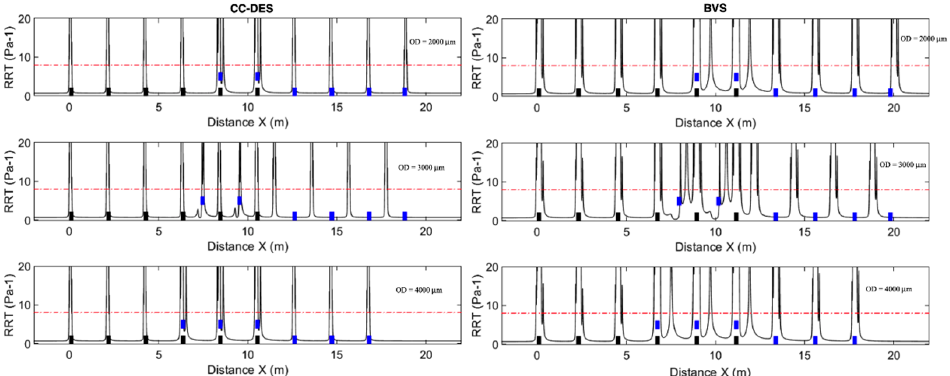
Figure 12. RRT distribution for overlapping configuration. For sake of simplicity, three representative configurations are displayed for each strut size (OD = 2000 µm, 3000 µm and 4000 µm). Strut locations on the X-axis are indicated with black (upstream stent) and blue rectangles (downstream stent). Notice that axial distance = 0 mm corresponds to the location of the first stent.